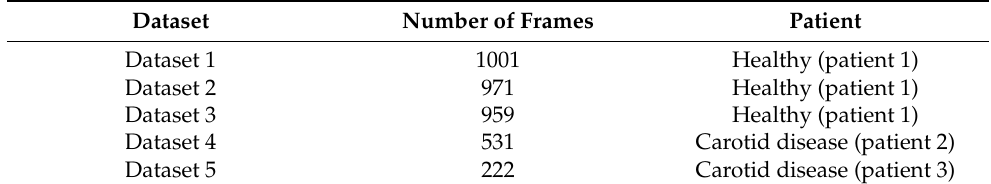
Table 1. Dataset total frames per class.